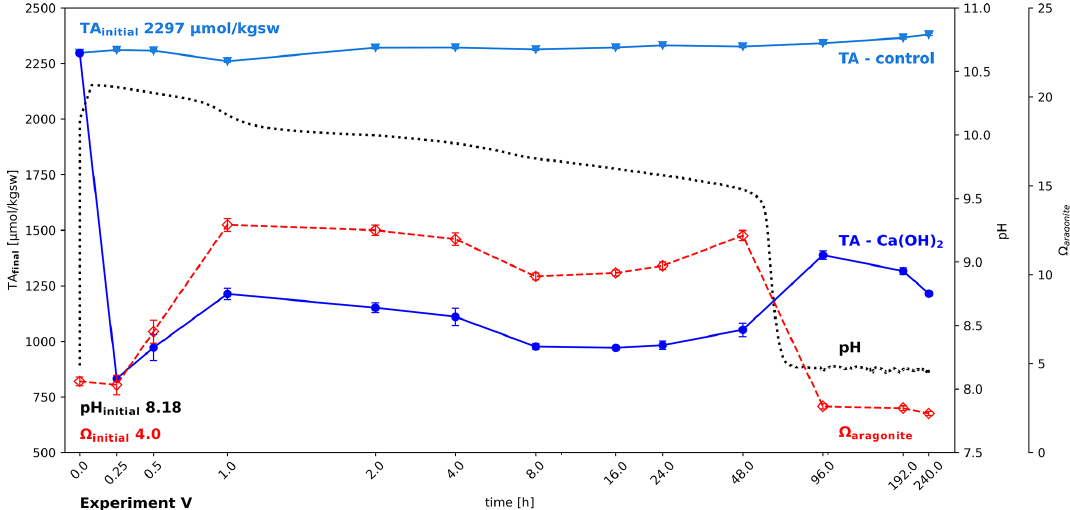
Figure 7. Partial recovery of alkalinity after carbonate precipitation; change in alkalinity, pH, and (cid:127) aragonite after adding 0.66gCa(OH) 2 kgsw − 1 to North Sea water in a shaking bath (simulating wave processes to allow accelerated air–water–CO 2 exchange). Ca(OH) 2 dissolution is so fast that it is hard to track. While the water gradually equilibrates with the atmosphere, a series of loss and gain of alkalinity can be